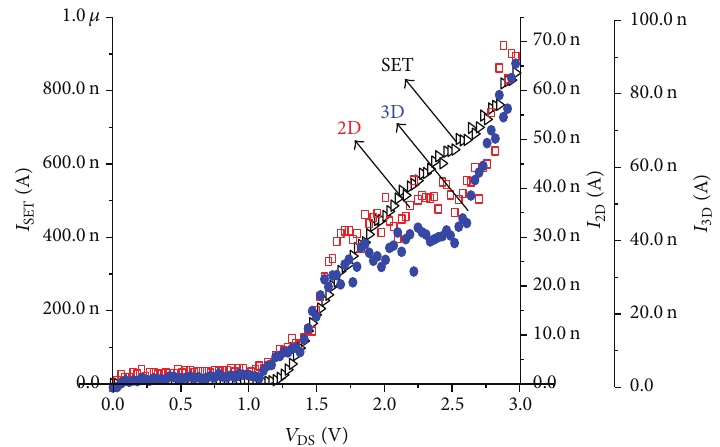
Figure 4: 𝐼 - 𝑉 characteristics of a SET and 2D and 3D at 300 K. DS